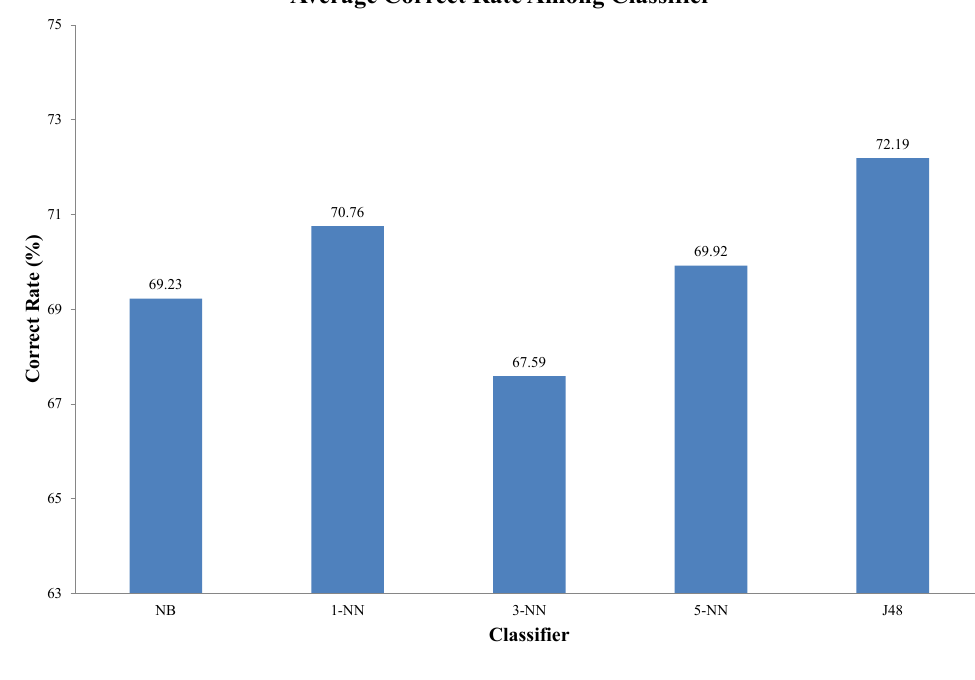
Figure 6. Average Correct rate comparison among